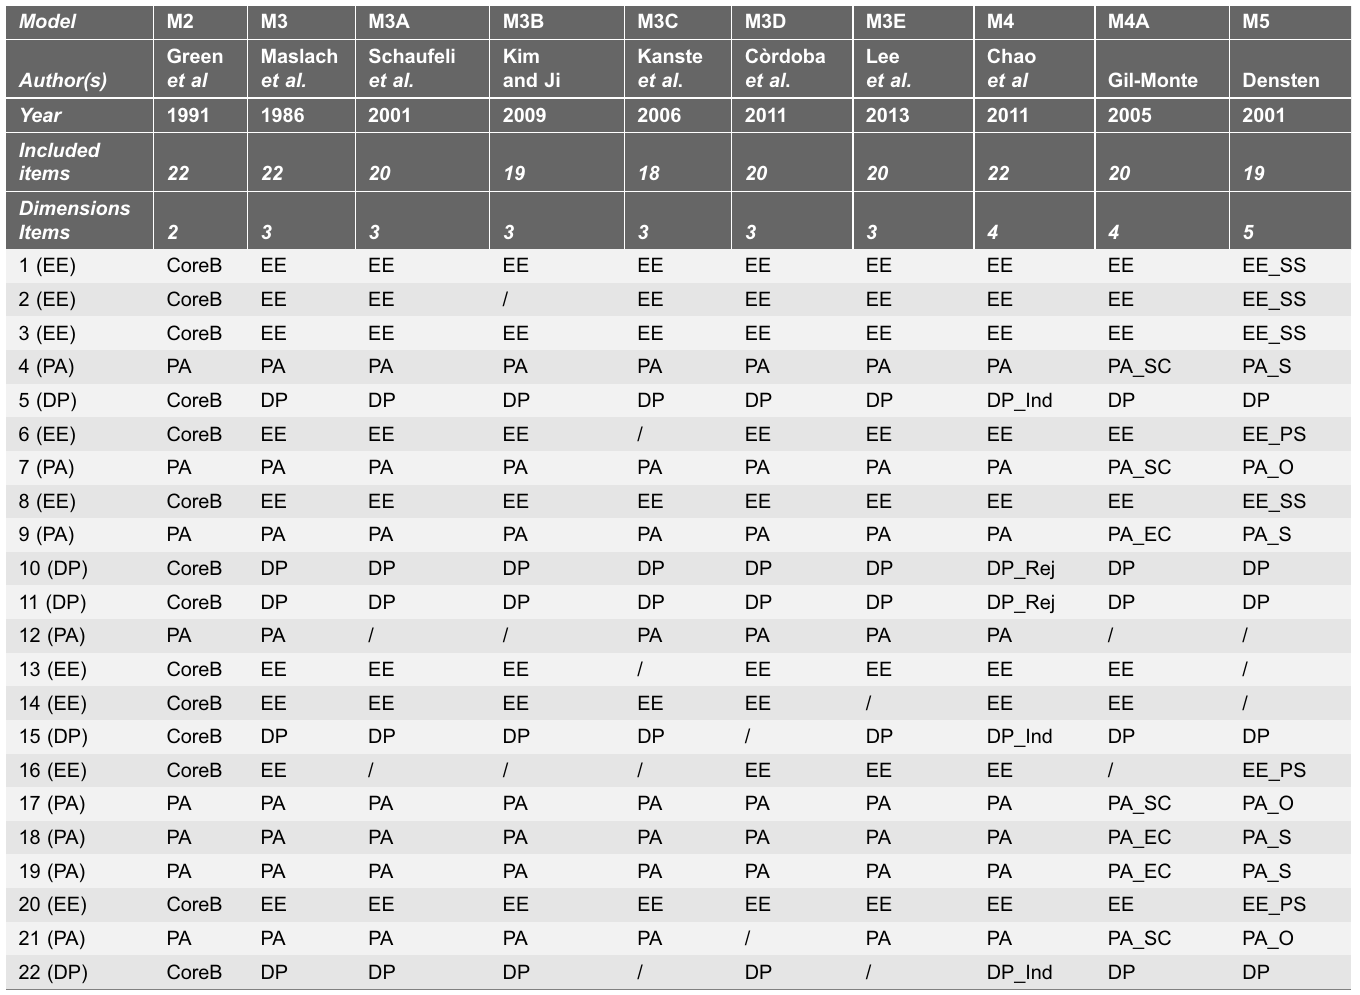
Table 2. Original and alternative measurement of MBI-HSS: items and model